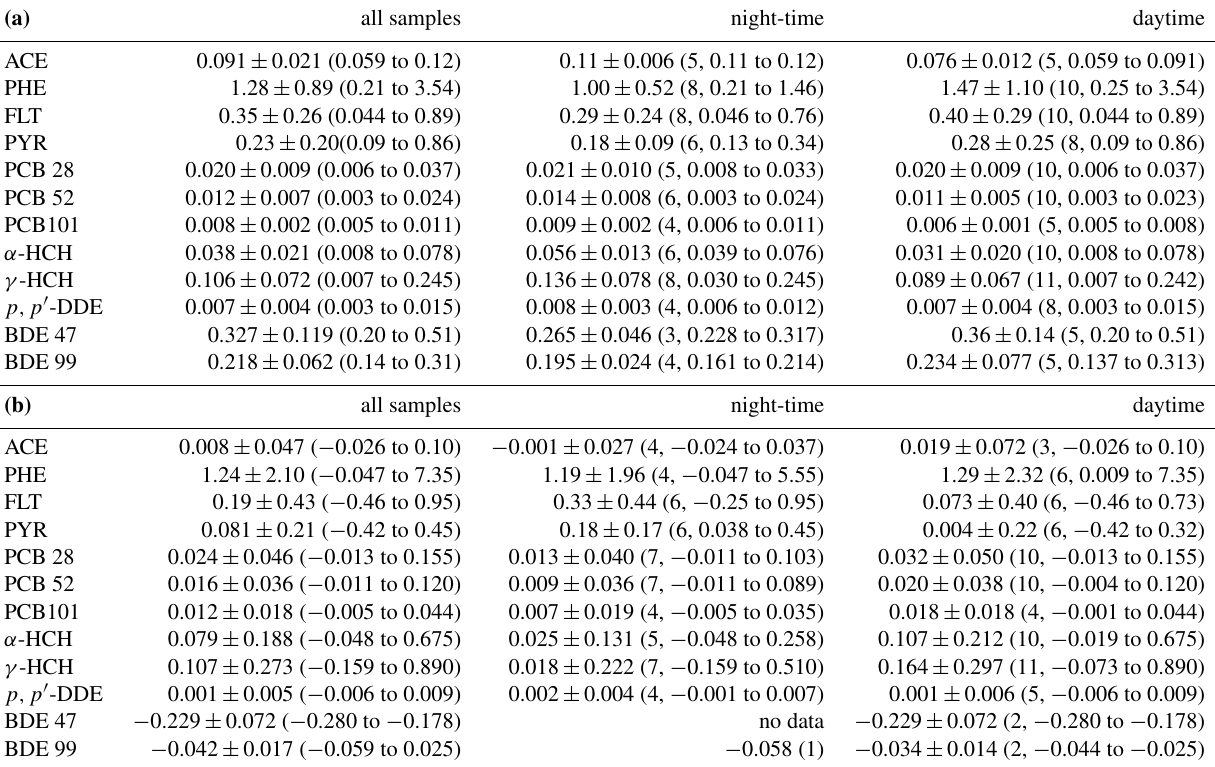
Table 1. Statistics of (a) concentrations at ground level, z 1 = 1 . 05m and (b) vertical gradients, (cid:49)c z , over (cid:49)z = 1 . 75m of gaseous PAHs and halogenated POPs. Mean ± standard deviation ( n , min–max), ngm − 3 , except PBDEs: pgm − 3 ) . All data are included (exceeding or below uncertainty thresholds). Individual data: see Tables S3, S4. For mean and standard deviations, values < LOQ were replaced by